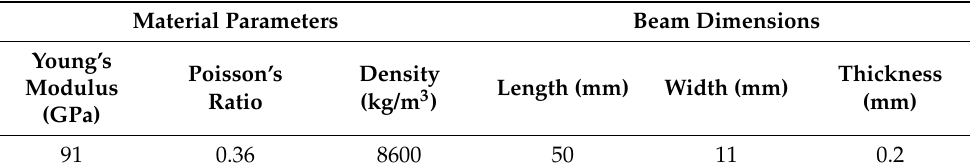
Table 1. Parameters for FEA simulation.